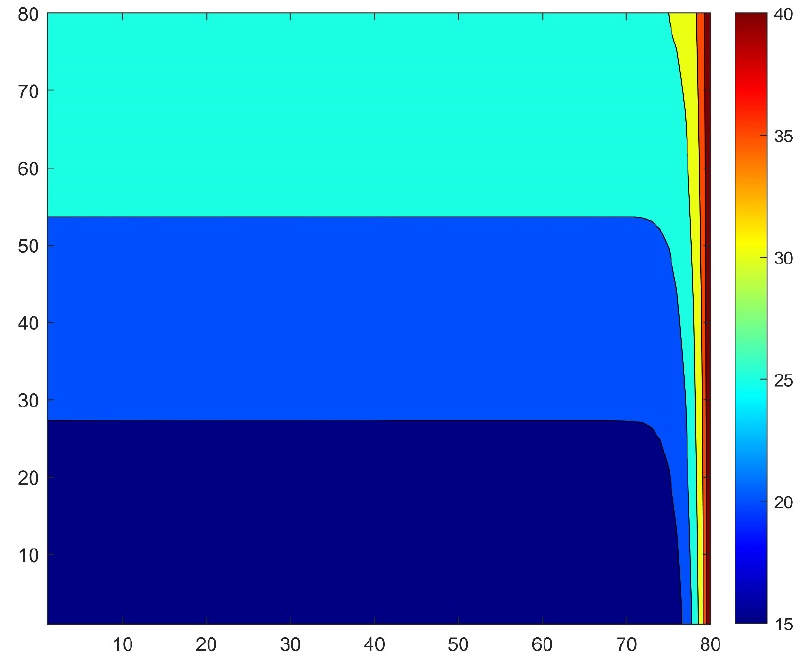
Figure 16. The maximum errors as a function of the time step size ∆ t for the equidistant mesh for a wall with insulation.